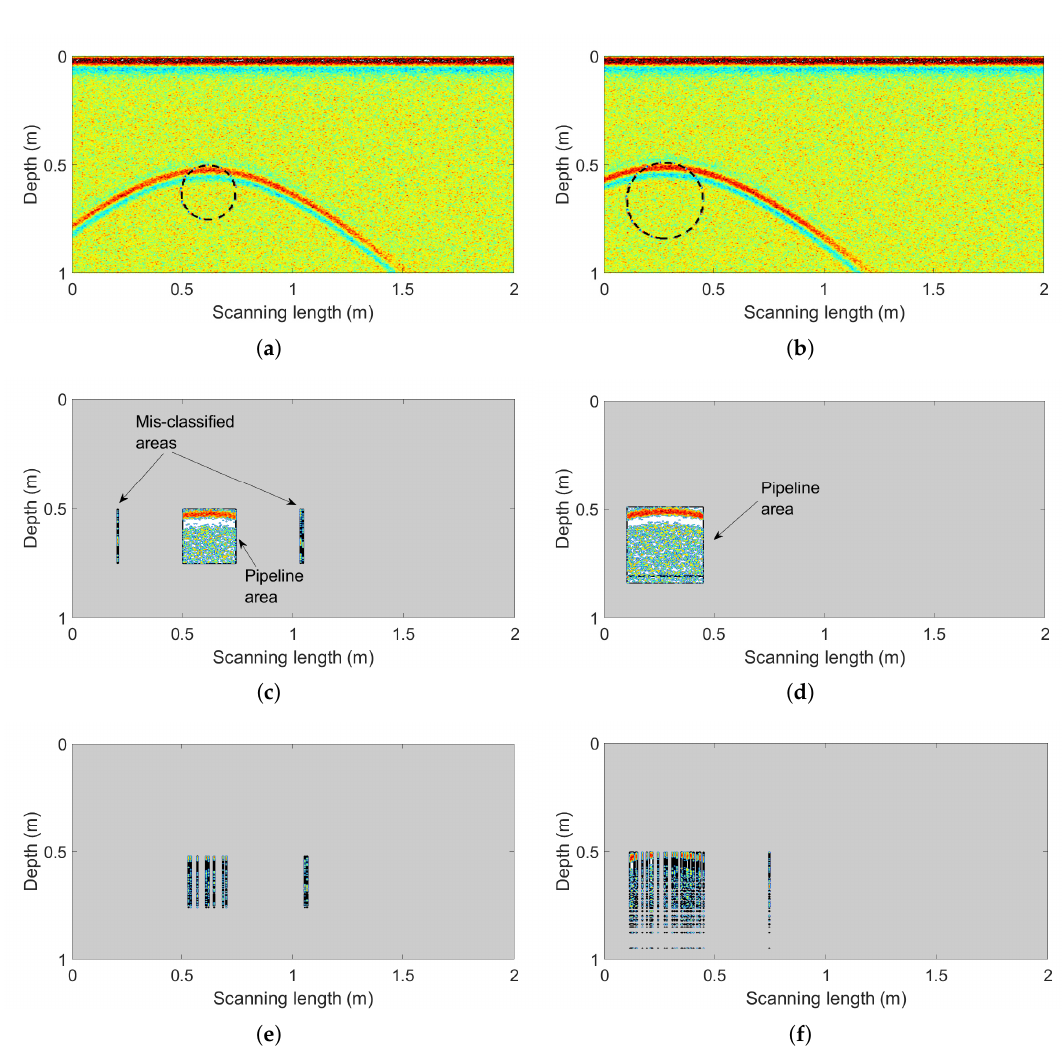
Figure 11. ( a ) The example noisy profile with a single pipeline (seen in Figure 9a). ( b ) Another example noisy profile with a single pipeline (seen in Figure 9b). ( c ) The reconstructed profile of panel (a) by the proposed learning framework. ( d ) The reconstructed profile of panel (b) by the proposed learning framework. ( e ) The reconstructed profile of panel (a) after the independent SVM for comparison. ( f ) The reconstructed profile of panel (b) after the independent SVM for